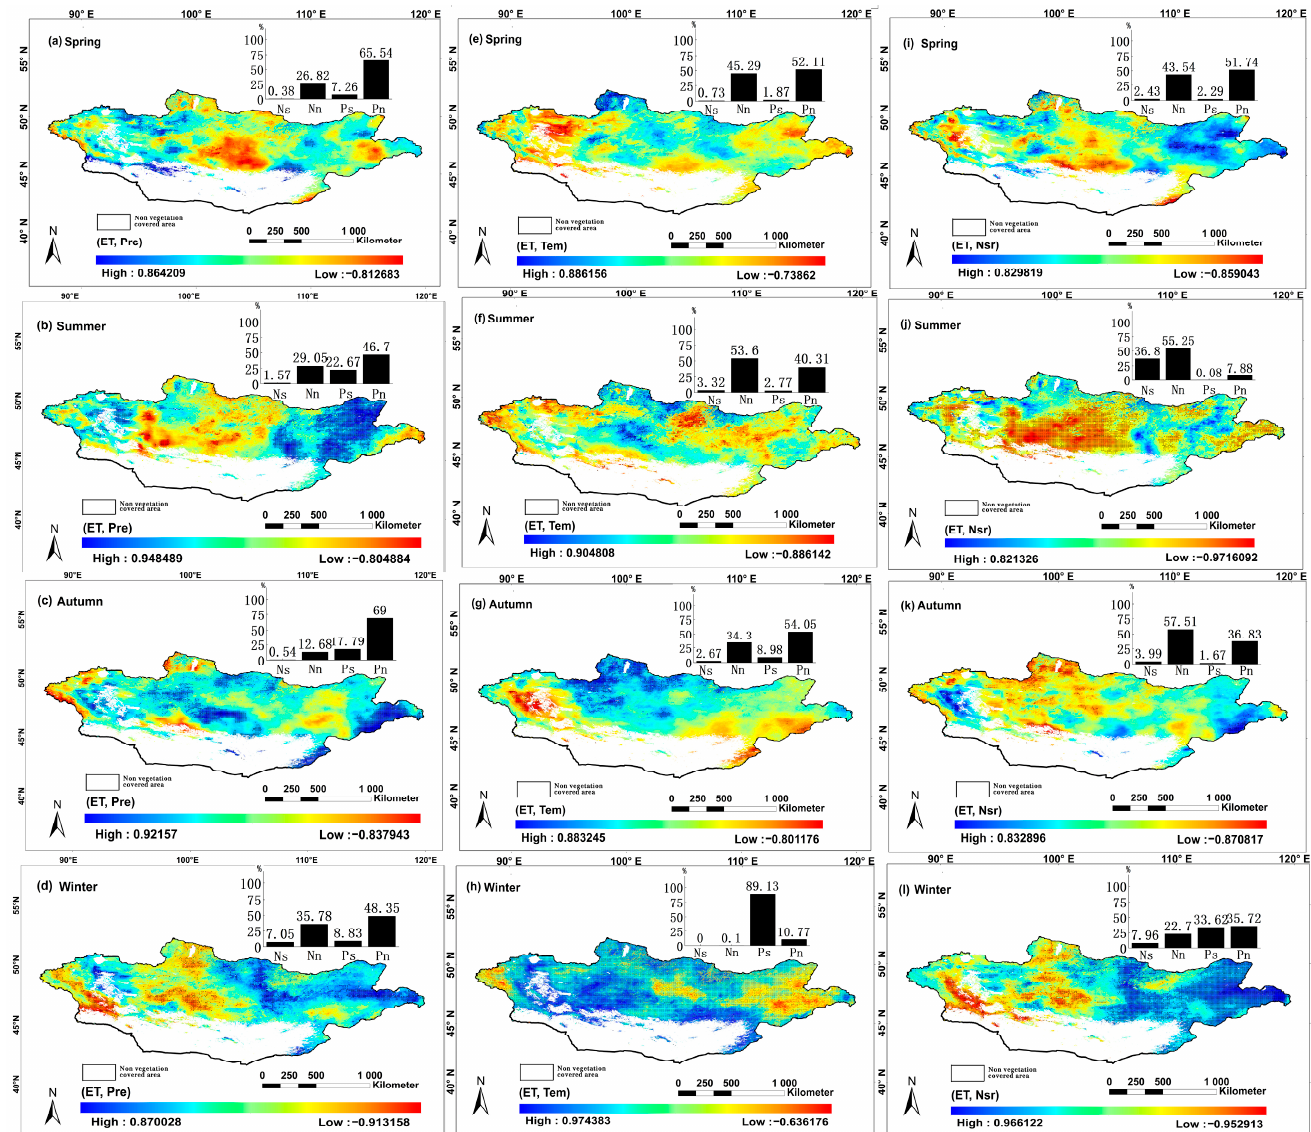
Figure 5. Spatial distributions of the partial correlation coefficients between ET and three meteoro- logical factors in all four seasons in Mongolia from 2001 to 2020: ( a – d ) Pre, ( e – h ) Tem, and ( i – l ) Nsr. The black dots show a significant correlation ( p < 0.05). The inset histograms display the percentages of Pn (not significantly positive), Ps (significantly positive), Nn (significantly negative) and Ns (not significantly negative) values.